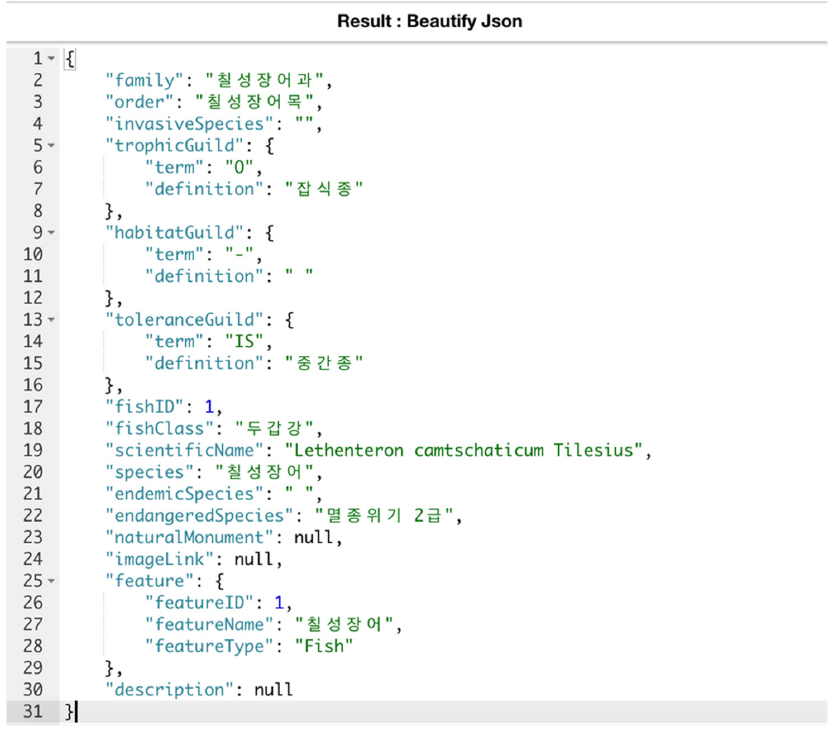
Figure 6. Well-formatted representation data for the fish species Arctic lamprey generated by an online formatting service (http://codebeautify.org/jsonviewer).